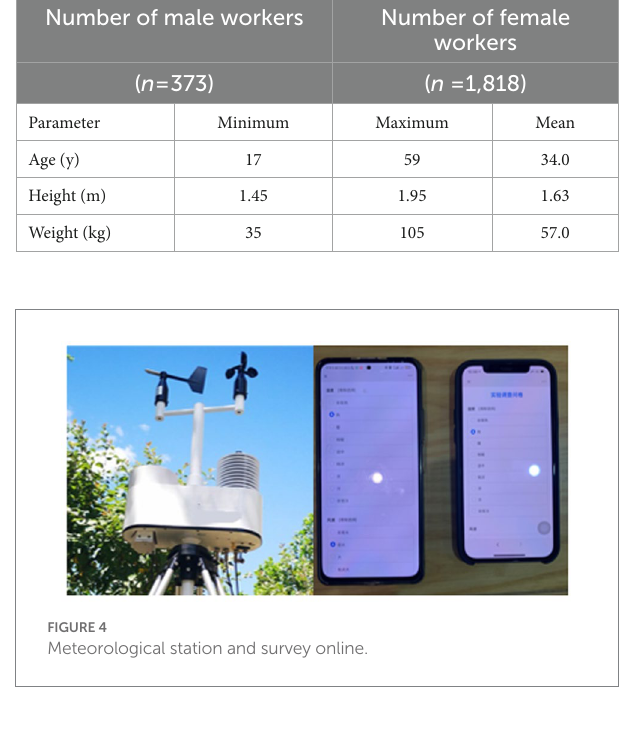
TABLE 3 Age distribution of the subjects.